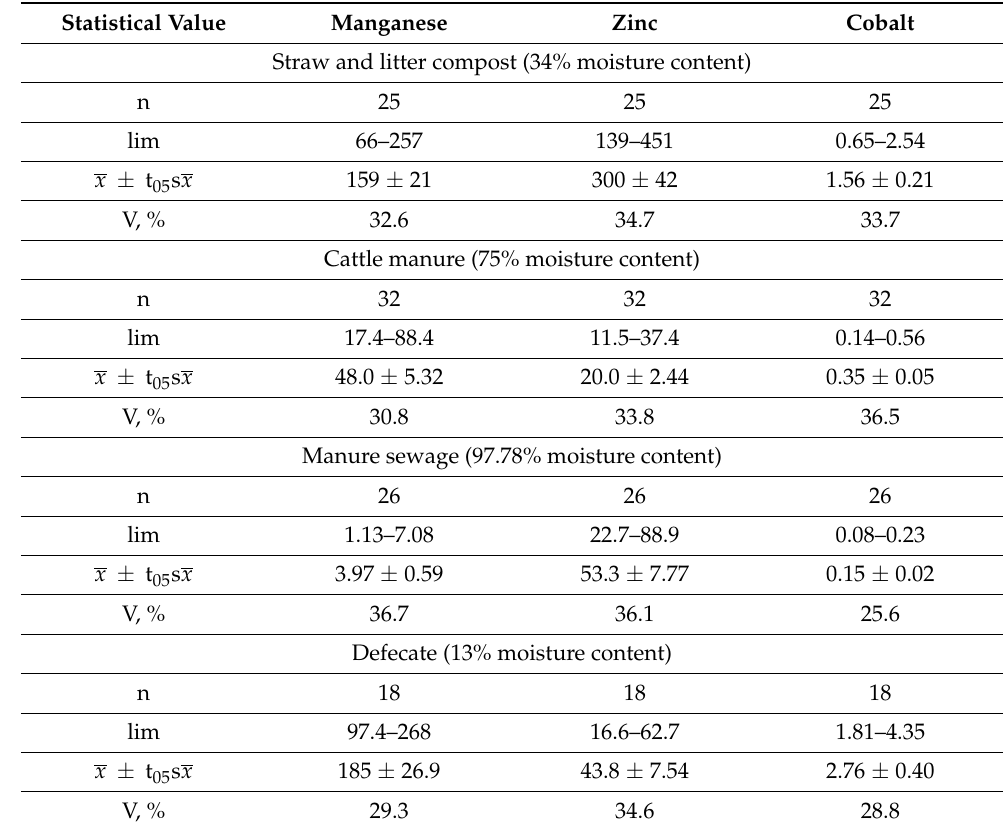
Table 8. Variation and statistical indices of trace element contents in organic fertilizers and defecate, mg/kg fertilizer with standard moisture